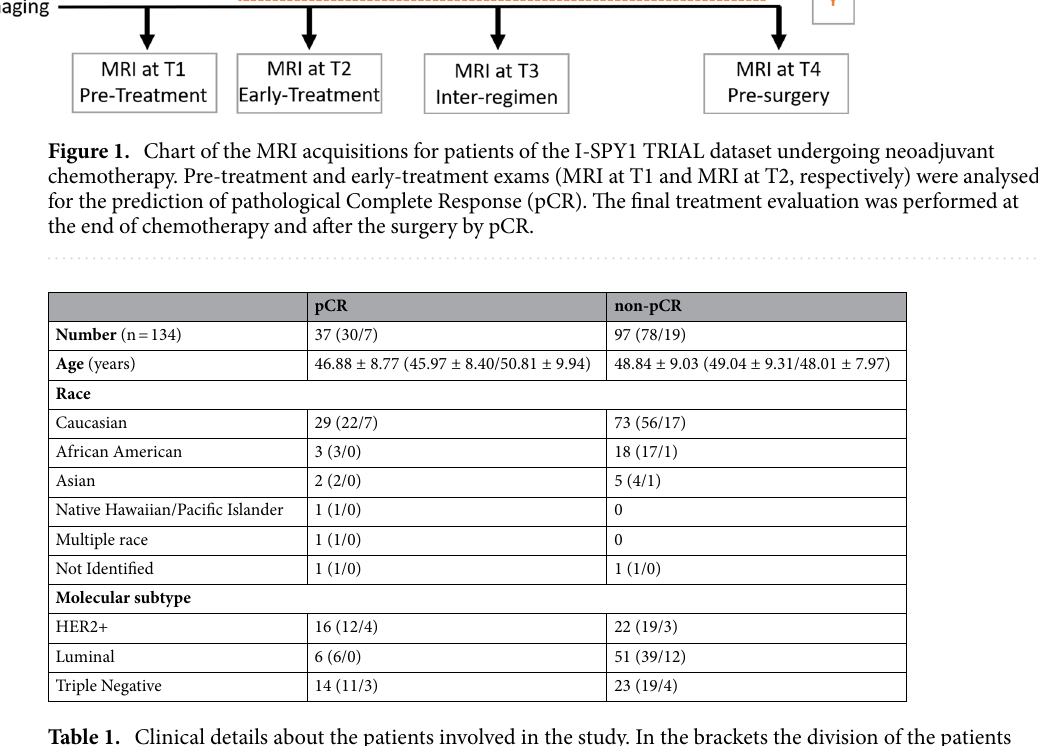
Table 1. Clinical details about the patients involved in the study. In the brackets the division of the patients between the fine-tuning dataset (first number) and the independent test (second number) is